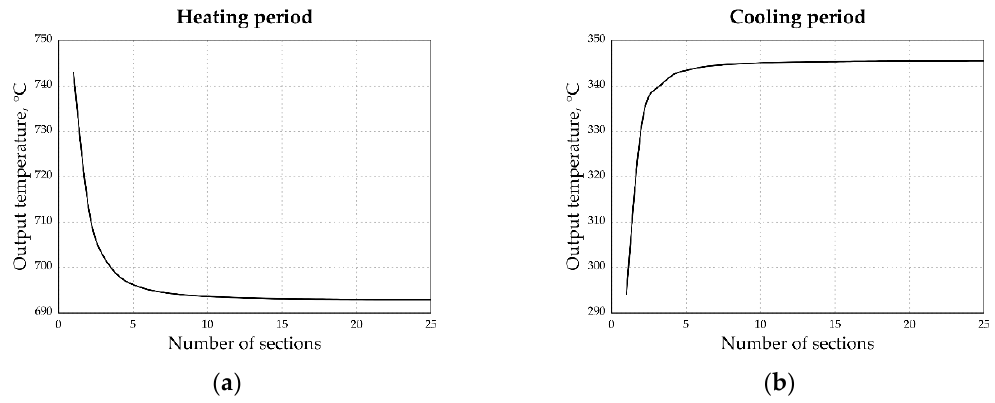
Figure 4. Influence of number sections on outlet temperature obtained by the basic calculation model: ( a ) for the heating period; ( b ) for the cooling period. ( a ) for the heating period; ( b ) for the cooling